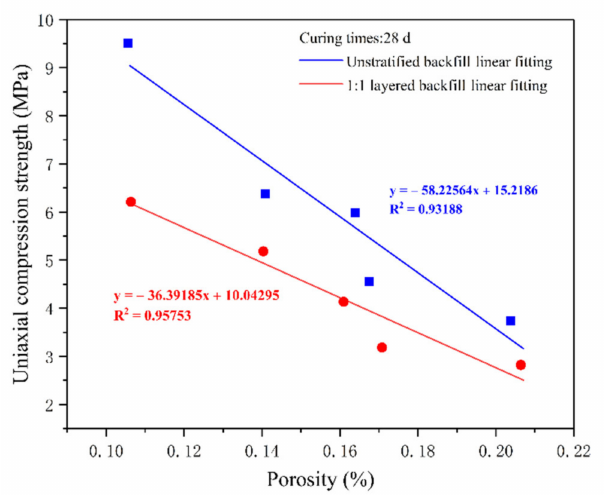
Figure 14. Fitting relationship between the porosity and uniaxial compression strength of